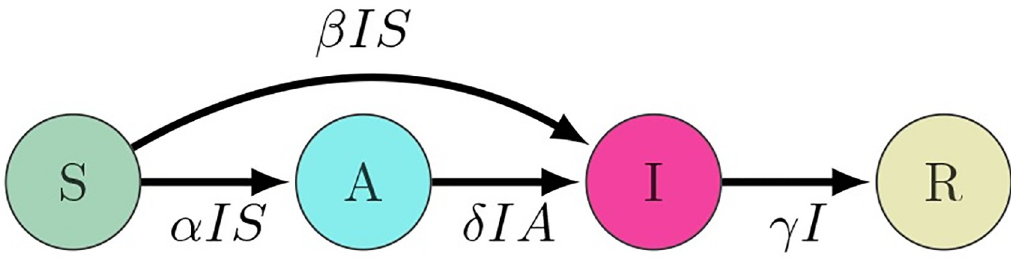
Fig 2. Diagram of the compartmental model. β is the contact rate, and γ is the rate of recovery. α is the rate of behavior change, and δ is the contact rate in the aware